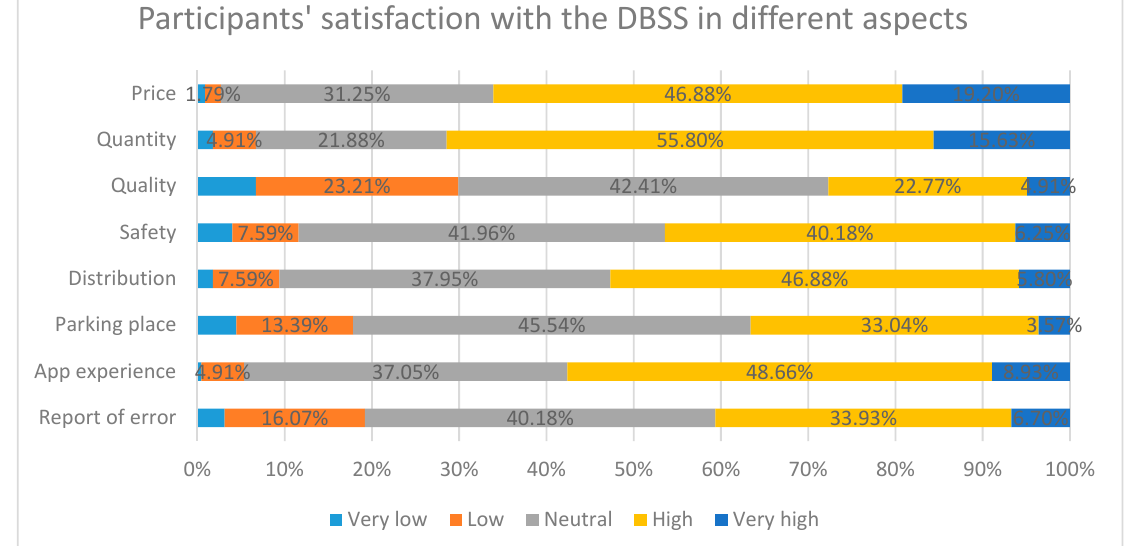
Figure 3. Participants’ satisfaction with the DBSS in different aspects.